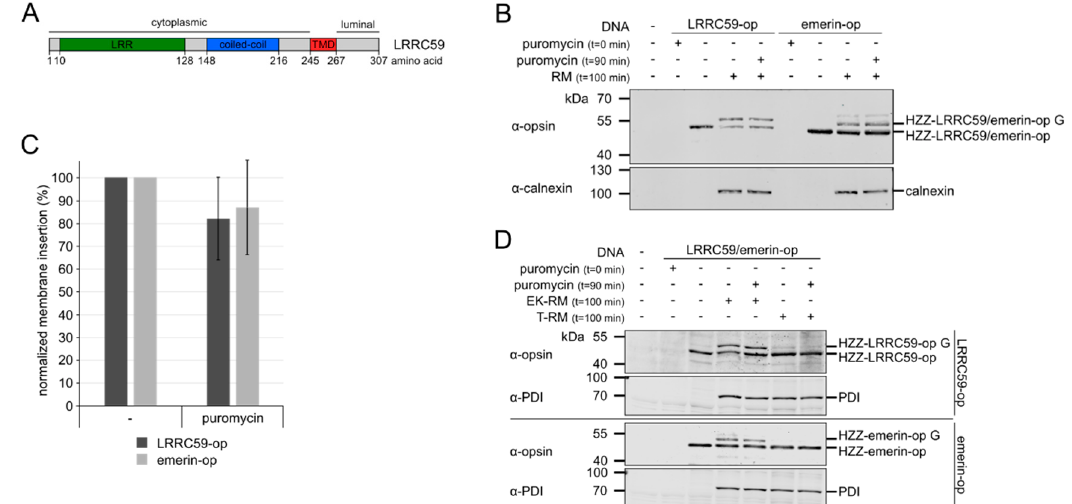
Figure 2. Posttranslational membrane insertion of LRRC59. ( A ) Schematic representation of full length LRRC59. The leucine rich repeat region (LRR), the putative coiled-coil domain and the transmembrane domain (TMD) are indicated. ( B ) Opsin-tagged LRRC59 (HZZ-LRRC59-op) and emerin (HZZ-emerin-op) were produced in vitro by coupled transcription-translation reactions in the absence ( − ) or presence (+) of rough microsomes (RM) and with (+) or without ( − ) the addition of puromycin. Proteins were analyzed by SDS-PAGE, followed by immunoblotting using antibodies against the opsin-tag and calnexin as loading control. G indicates the glycosylated forms of LRRC59-opsin and emerin-opsin. ( C ) Quantification of the results in ( B ). The error bars indicate the standard deviation from the mean of six independent experiments. ( D ) Membrane insertion of HZZ-LRRC59-op or HZZ-emerin-op after in vitro transcription-translation reactions into EDTA/high-salt (EK-RM) or trypsin-treated (T-RM) microsomes with (+) or without ( − ) addition of puromycin. Proteins were analyzed by SDS-PAGE, followed by immunoblotting using antibodies against the opsin-tag and PDI as loading control.